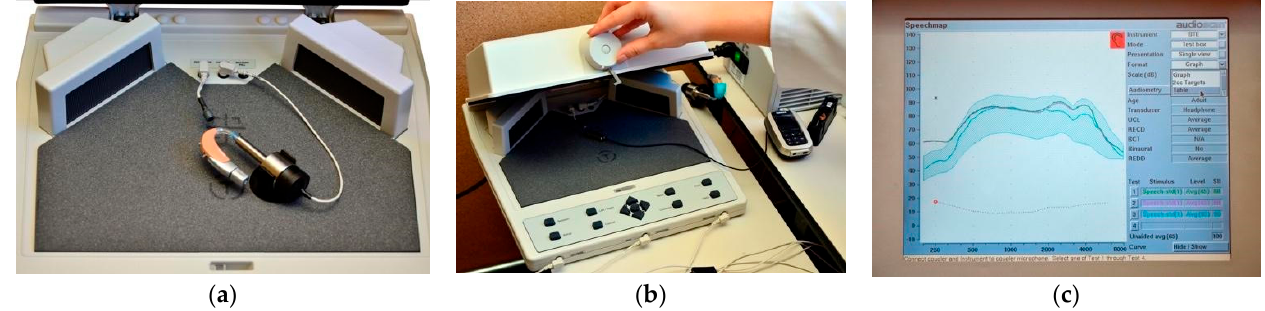
Figure 2. Set-up of electroacoustics measurement. ( a ) The HA plus RMS receiver inside the box; ( b ) the transmitter’s microphone inside the box; ( c ) frequency response curves for the HA and RMS.